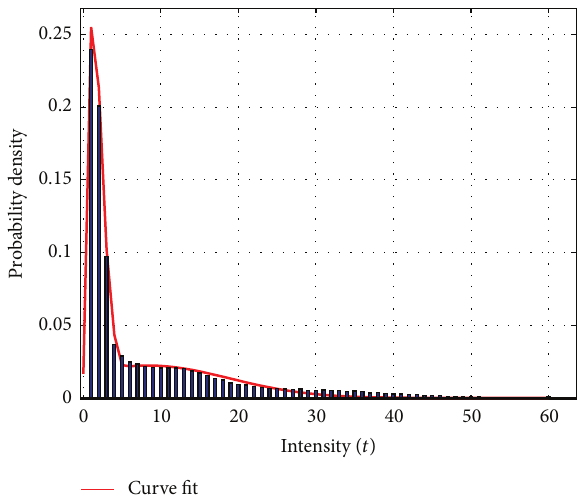
Figure 13: Weibull distribution fitting.